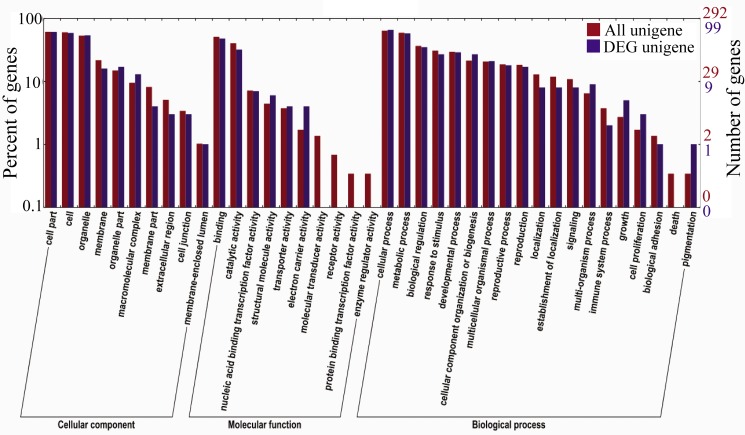
Significant gene ontology (GO) analysis of miRNA targets.The targeted genes of differentially expressed miRNAs in the ‘G1208’ and ‘H1201’ are analyzed in this figure. The left-hand scale is the percent of targeted gene numbers corresponding to GO terms. The right-hand scale is targeted gene numbers corresponding to GO terms. Red bar, all unigenes. Blue bar, differentially expressed genes’ unigenes.